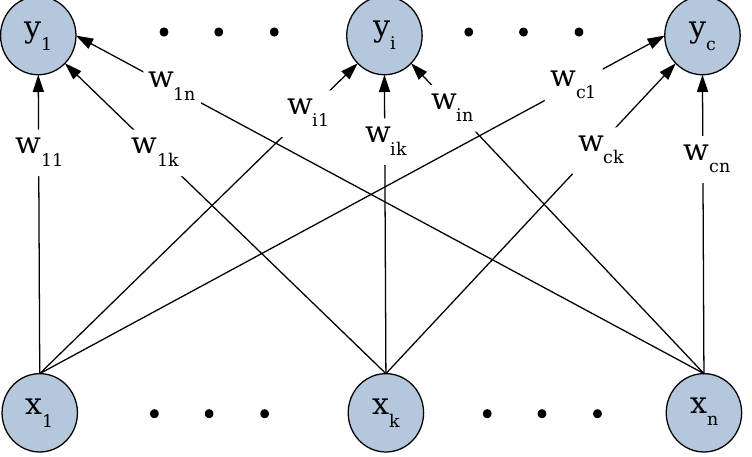
Figure 1. Structure of a competitive neural network. { x 1 , x 2 ,..., x n } and { y 1 , y 2 , ..., y n } are the components of input and output vectors of the network, respectively, and { w 11 , w 12 , . . . , w cn } are the synaptic weights of the c output neurons. This structure is the basis of the multi-competitive-layer architecture we propose in this